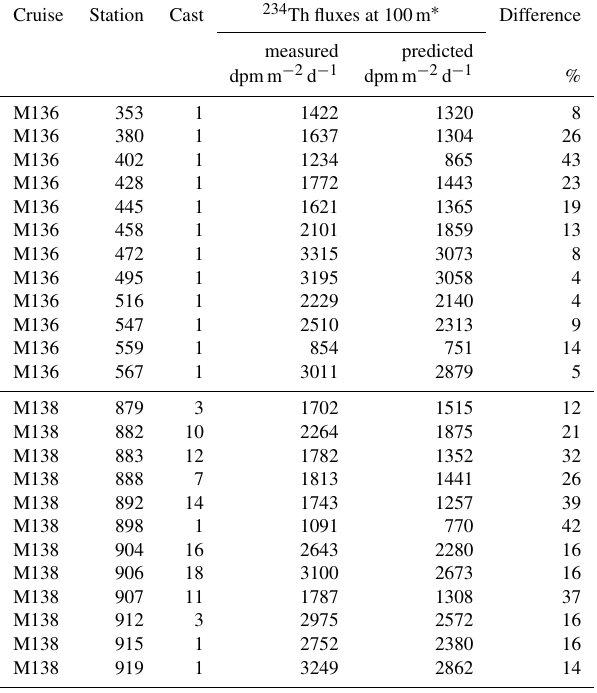
Table 2. Comparison of 234 Th fluxes at 100 m calculated with mea- sured 238 U activities and those with salinity-based 238 U.